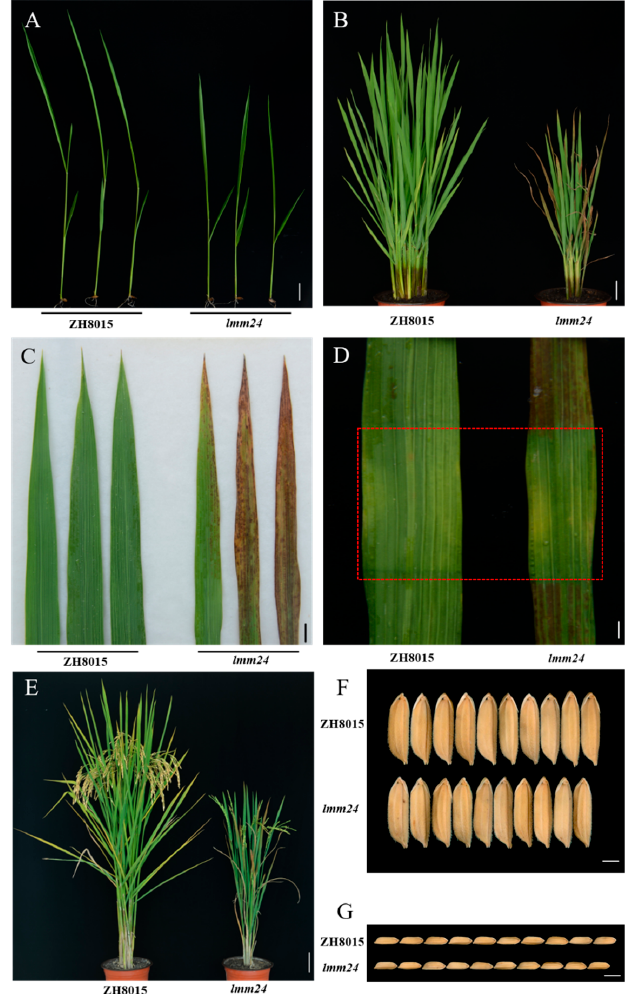
Figure 1. Phenotypic analyses of lmm24. ( A ) Comparison of growing situation ZH8015 and lmm24 at seedling stage (15 days post-sowing (dps)). ( B ) lmm24 plant at tillering stage (50 dps) display dark brown lesions. ( C ) Lesion mimic phenotype in lmm24 and clean leaf blade in ZH8015. ( D ) Determination of whether the lmm24 phenotype was light dependent. The area covered with aluminum was indicated by red rectangle frame. ( E ) ZH8015 and lmm24 plants at harvest period ( F ) Grain width observation of lmm24 and ZH8015. ( G ) Grain length observation of lmm24 and ZH8015. Scale bar: 2 cm in ( A , C ), 1 cm in ( D , F , G ), 10 cm in ( B , E